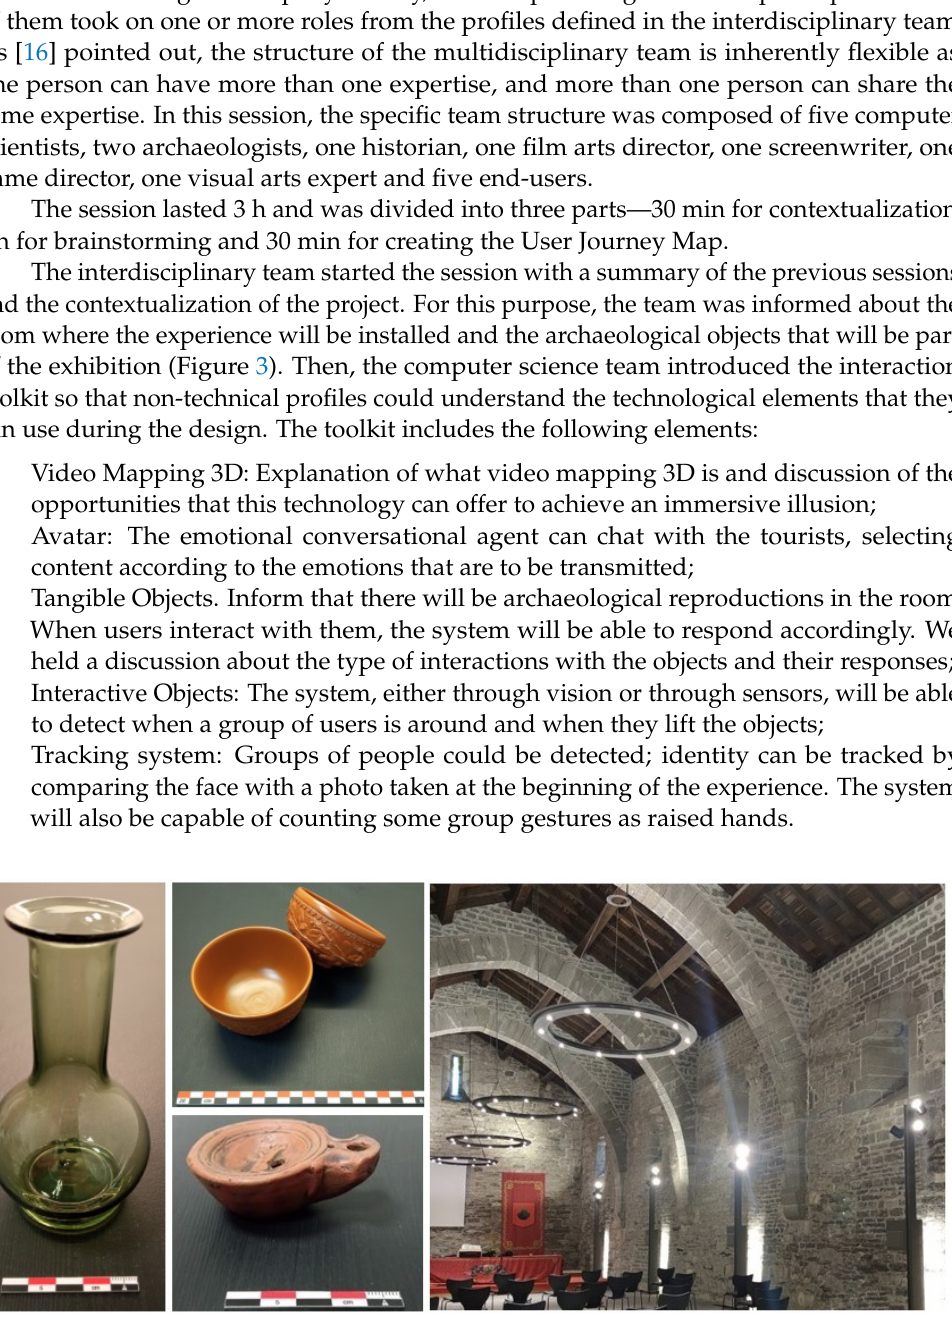
Figure 3. Cultural Heritage: Roncesvalles Room and Archaeological objects used as interactive